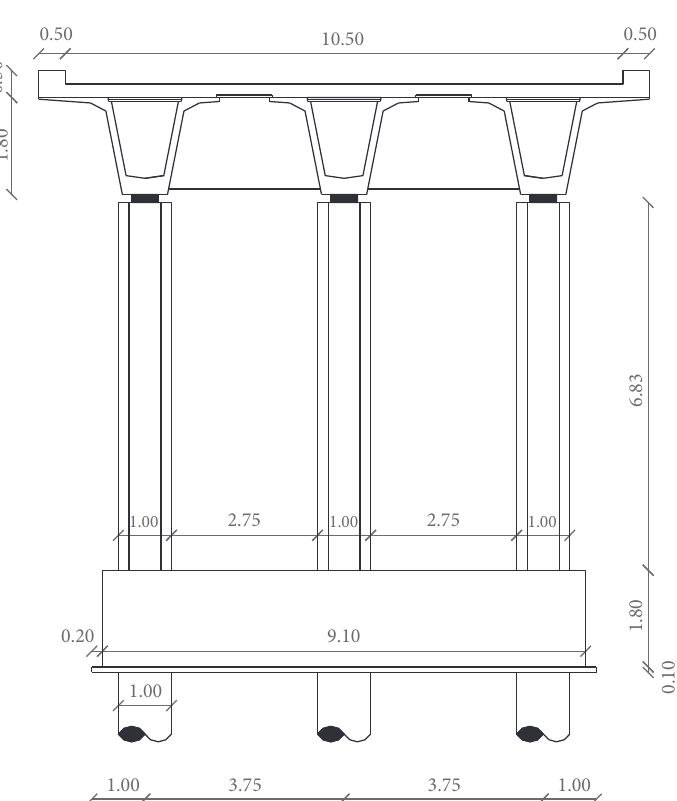
Figure 2: Lateral view of the pier columns with cross-section of the deck.